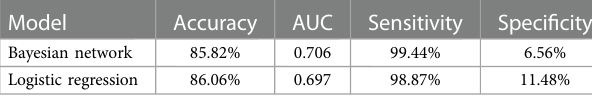
AUC, area under the curve; CI, con fi dence interval.